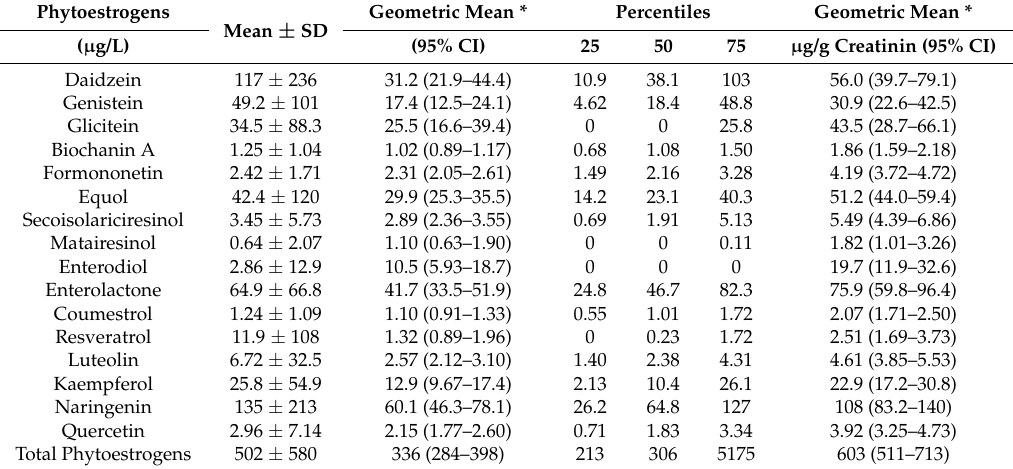
Table 5. Urinary concentrations of phytoestrogens during 12-h urine collection period ( n =